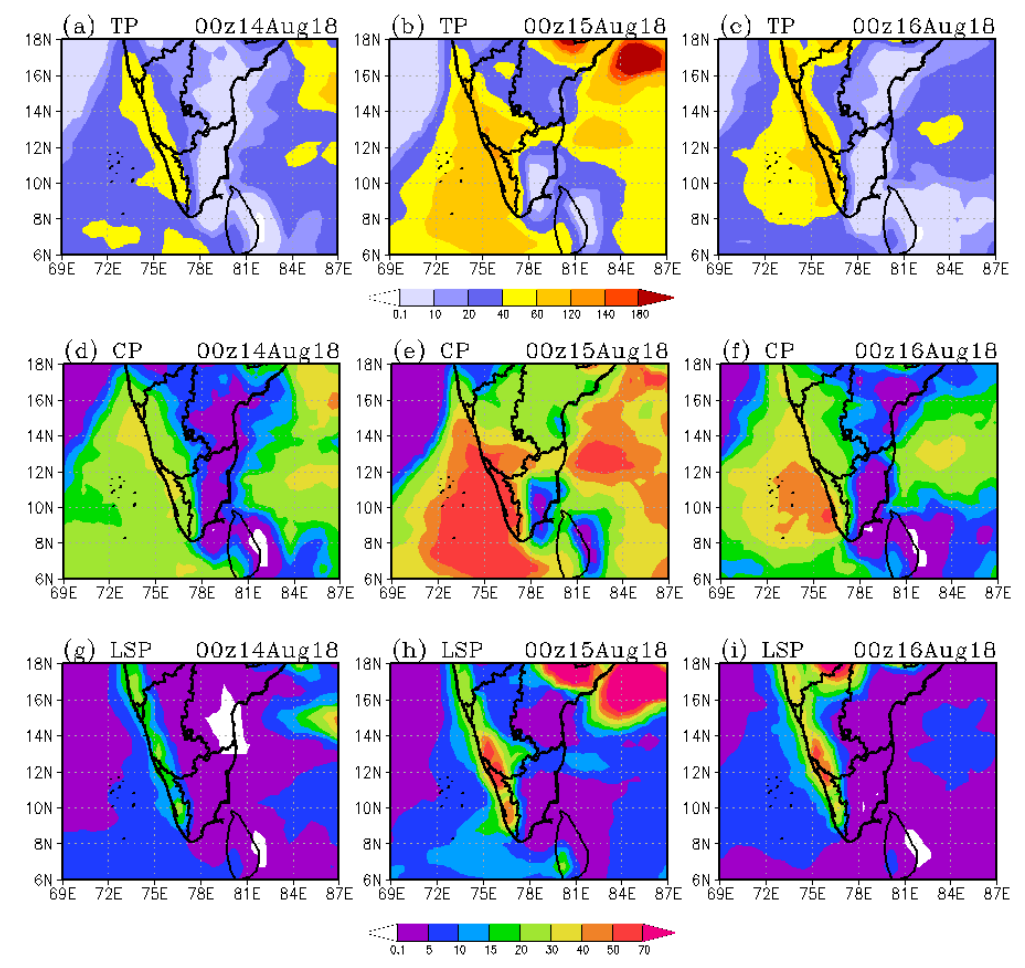
Figure 5. ( a – c ) 24-h accumulated rainfall (mm · d − 1 ) distributions valid at 0300 UTC on 14 August 2018, 0300 UTC on 15 August 2018, and 0300 UTC on 16 August 2018, respectively, derived from IMD + TRMM merged analysis. Figure ( d – f , g – i ) is the same as ( a – c ), but for convective and large-scale stratiform precipitation (mm·d − 1 ERA-Interim reanalysis), respectively. Both the datasests used 25 km resolutions.